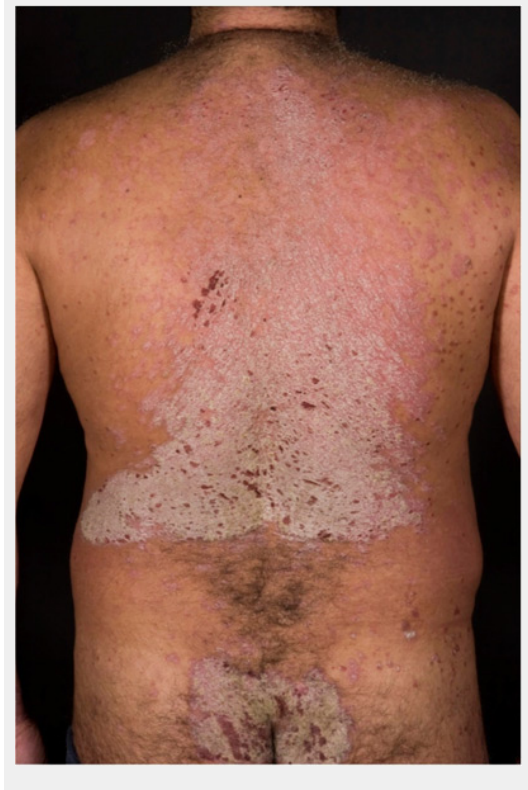
Figure 1 Chronic plaque-type psoriasis. This classical clinical manifestation of psoriasis is characterised by well demarkated, red, infiltrated plaques, covered with a coarse silvery scaling. Here, the lumbar region as a predilection site is